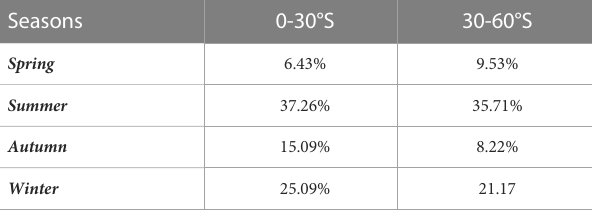
TABLE 2 The regional partition distribution of windseas energy to total waves in different seasons. Seasons